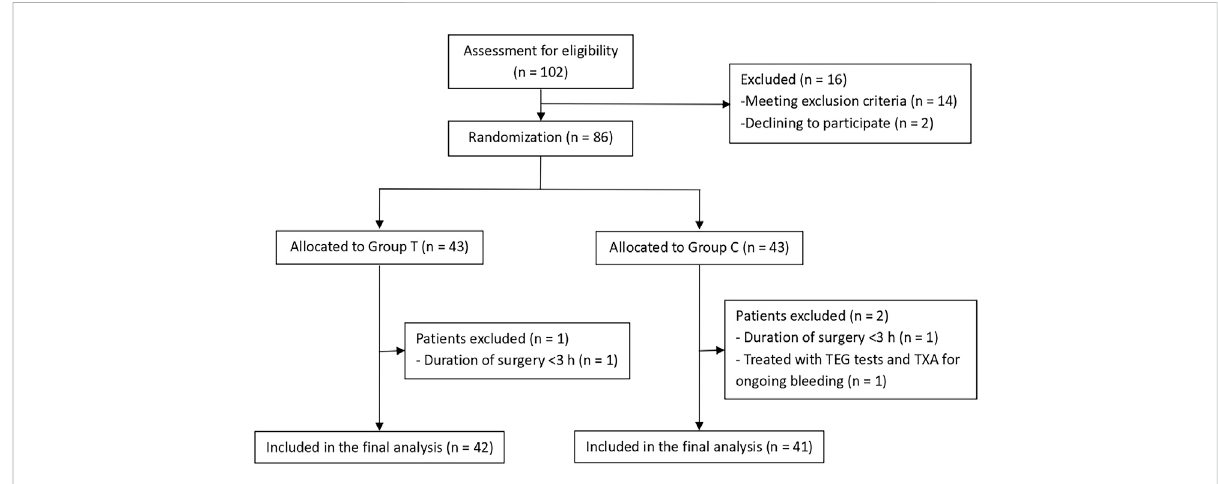
FIGURE 2 Flow chart of the study. TEG, thromboelastography; TXA, tranexamic acid.